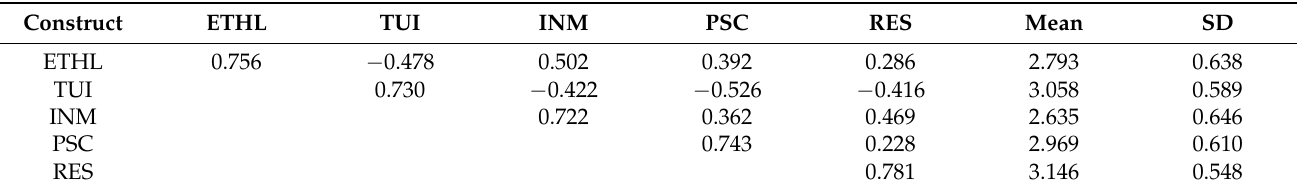
Table 5. Correlations and discriminant validity.